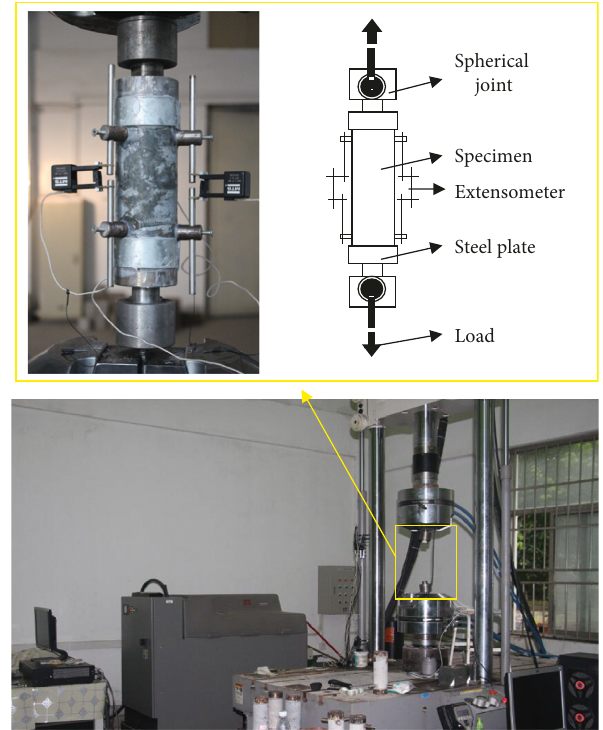
Figure 3: Extensometer of MTS322 electrohydraulic servoloading